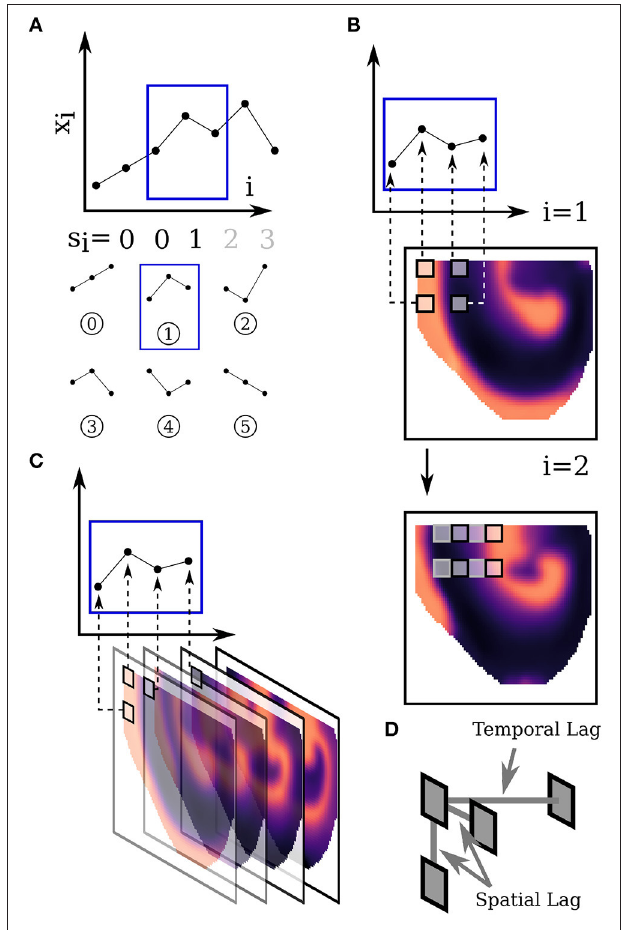
FIGURE 1 | Construction of temporal (A) , spatial (B) and spatiotemporal (C) PE. (D) Shows the tripod used for STPE. See text in sections 2.1, 2.2, 2.3 for details. (A) Shows the extraction of one-dimensional order patterns from a time series x i and the assignment to symbols s i . (B) Illustrates how two-dimensional order patterns are sampled from an individual image. The 2 × 2 sampling-grid is moved over all possible positions of the image. (C) Sketches how three-dimensional order patterns are extracted from subsequent images which form the video under